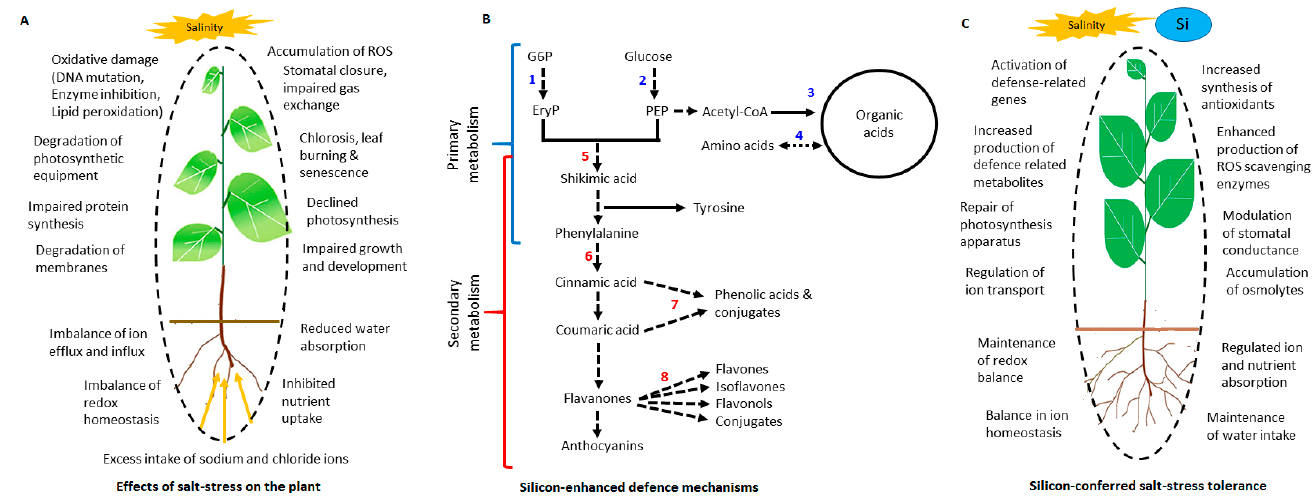
Figure 9. A postulated overview of Si-mitigated alleviation of salt stress effects on tomato plants via modulation of the primary and secondary metabolic pathways. ( A ) Scheme portraying the detrimental effects of salt stress on a plant. Excess accumulation of Na + and Cl − ions in the soil, hence an increased absorption causes an imbalance in the uptake of other ions, water and nutrients. Subsequent ionic and osmotic stresses enhance synthesis of ROS, resultant in oxidative damage of macromolecules and photosynthetic equipment. ( B ) Si-based biostimulant treatment of the salt-stressed plants leads to modifications in the slightly overlapping primary (red) and secondary (blue) metabolic pathways for a coherent defence response. Upregulation of these pathways result in accumulation of osmolytes, enhanced synthesis of enzymatic and non-enzymatic antioxidants, ROS detoxification and repair of the salt-stress induced oxidative damage. Coherent activities of the Si-enhanced defence responses ultimately lead to conferred salt stress tolerance in plants ( C ). Primary metabolic pathways (blue): glycolysis (1), pentose phosphate pathway (2), tricarboxylic acid cycle (3), amino acid biosynthesis pathways (4) and the secondary metabolic pathways (red): including shikimate pathway (5), phenylpropanoid pathway (6, 7) and flavone and flavonol biosynthesis pathways (8). Abbreviations: G6P, Glucose-6-phosphate; EryP, Erythrose phosphate; PEP, Phosphoenol